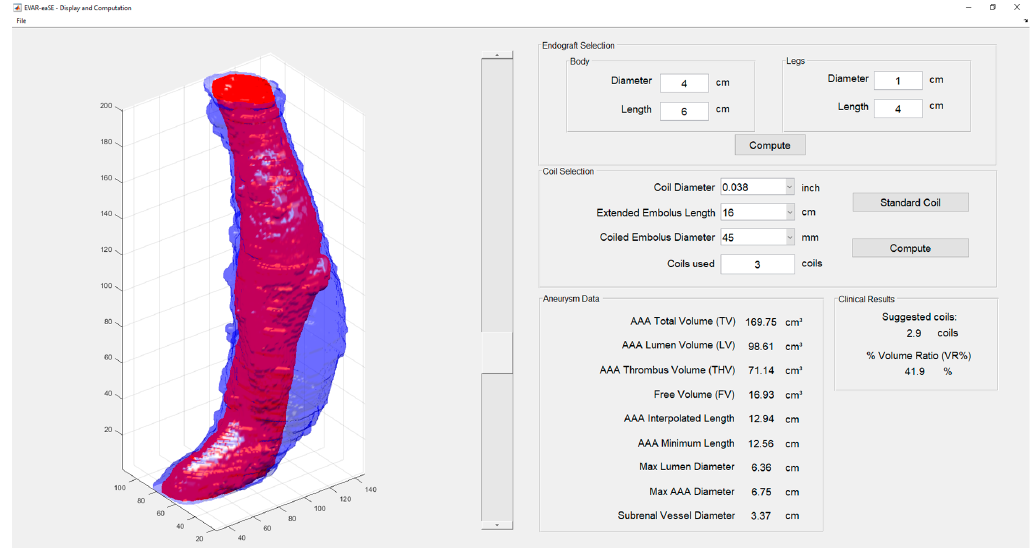
Figure 4. Graphical user interface of Display and Computation Window (DCW).